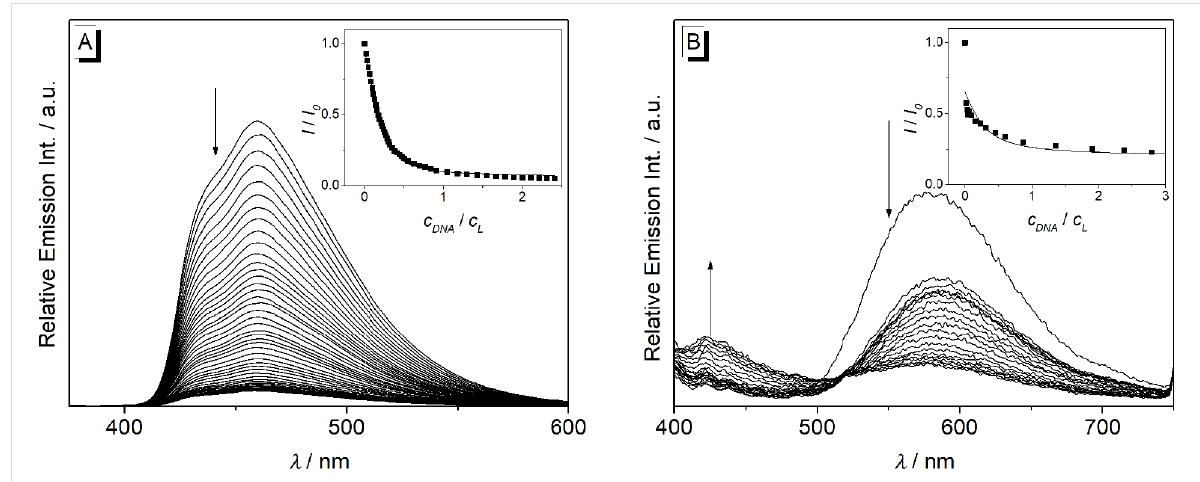
Figure 9: Fluorimetric titration of 2a (A) and 2d (B) with 22AG in potassium phosphate buffer (95 mM K + ; 5% DMSO; pH 7.0); c Ligand = 20.0 μ M. Arrows indicate the development of the bands with increasing DNA concentration. Inset: Plot of the relative emission intensity, I / I 0 versus c DNA / c L . Lines denote the best fit of experimental data to the theoretical model; λ ex = 335 nm (A) and 380 nm